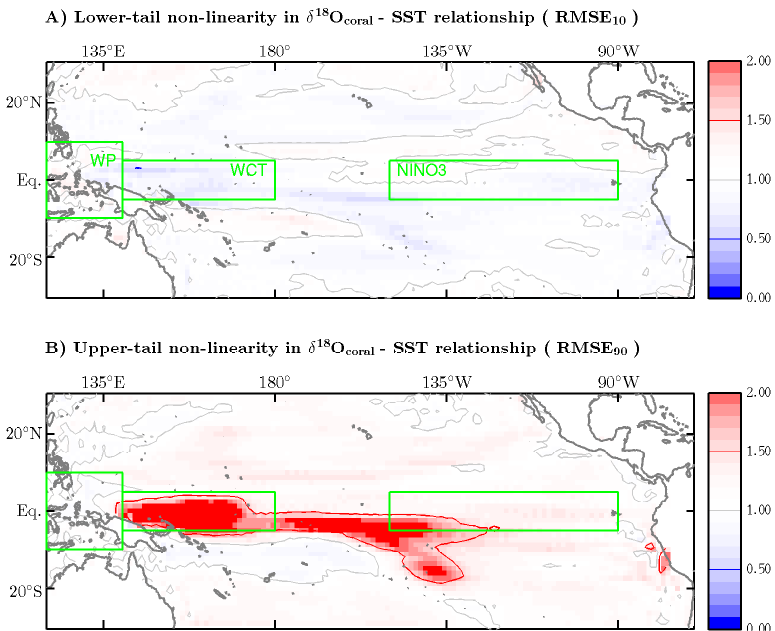
Fig. 4. The spatial distributions over the tropical Pacific domain of (A) the RMSE 10 non-linearity metric, which shows the extent of non-linearity in the model δ 18 O coral –SST relationship for the eastern Pacific La Ni˜na tail of ENSO events and (B) The RMSE 90 non-linearity metric, which shows the extent of non-linearity in the model δ 18 O coral –SST relationship for the eastern Pacific El Ni˜no tail of ENSO events. The three regional boxes discussed in the text are highlighted in green, WP = Warm Pool, WCT = Western Cold Tongue.